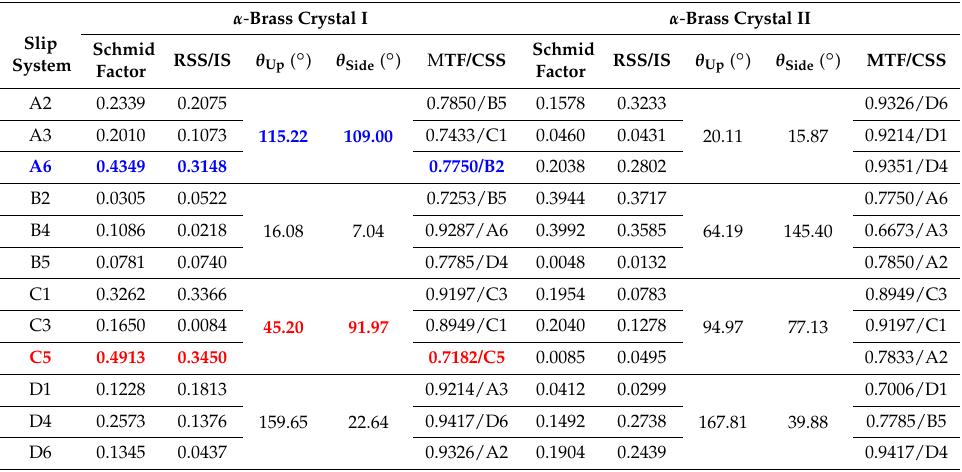
Table 2. Slip system analyses for α -Brass micro-pillar. The first active slip system is marked in red and the second one in blue. The compressive direction is along X, the GB normal along Y and the upper face normal along Z as presented in Figure